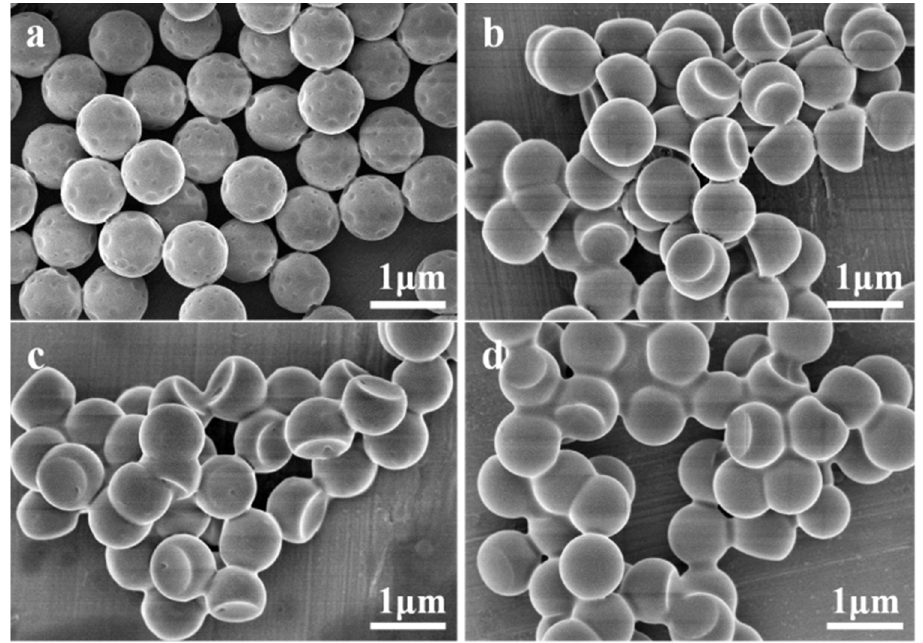
Figure 3. SEM images of PS/P(OFMA-S) composite particles obtained with constant w OFMA / w St of 1 and different w PX / w PS : ( a ) 1, ( b ) 3, ( c ) 4, ( d ) 6 at 80